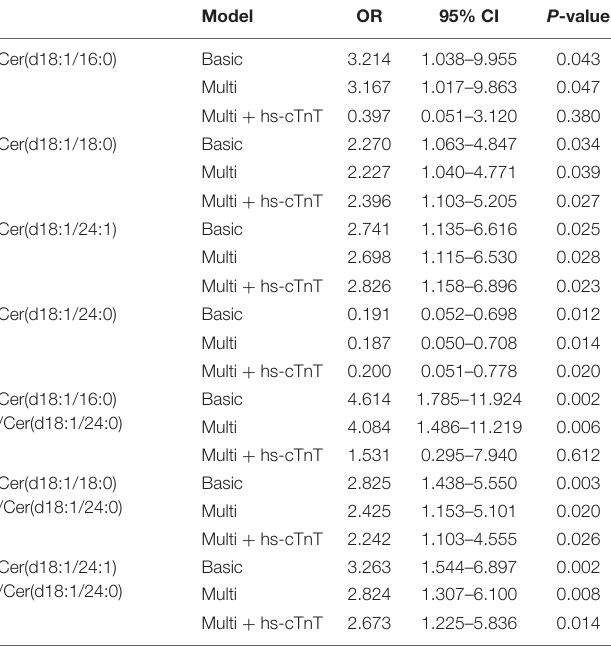
TABLE 3 | Association between plasma ceramides and the risk of ACS-DM.